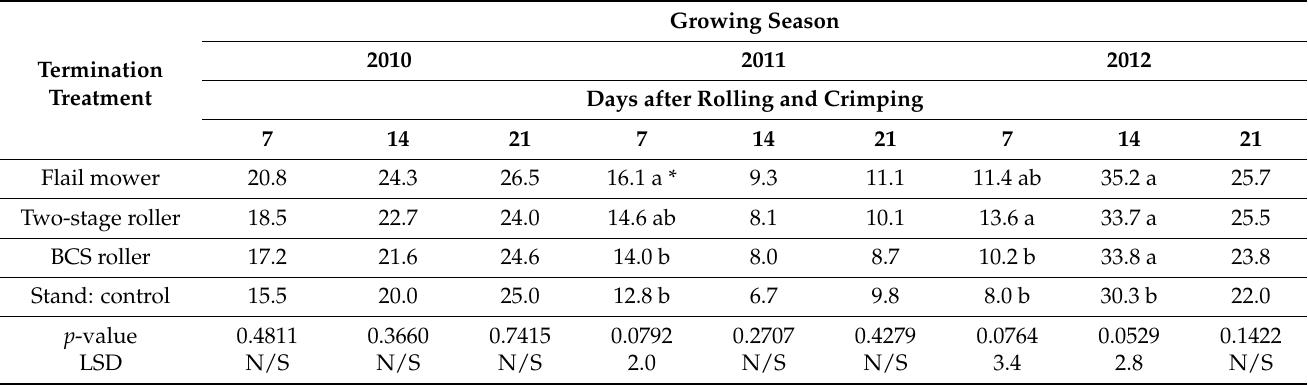
Table 10. Volumetric moisture content (VMC in %) for crimson clover during three weeks of evalua- tion for three growing